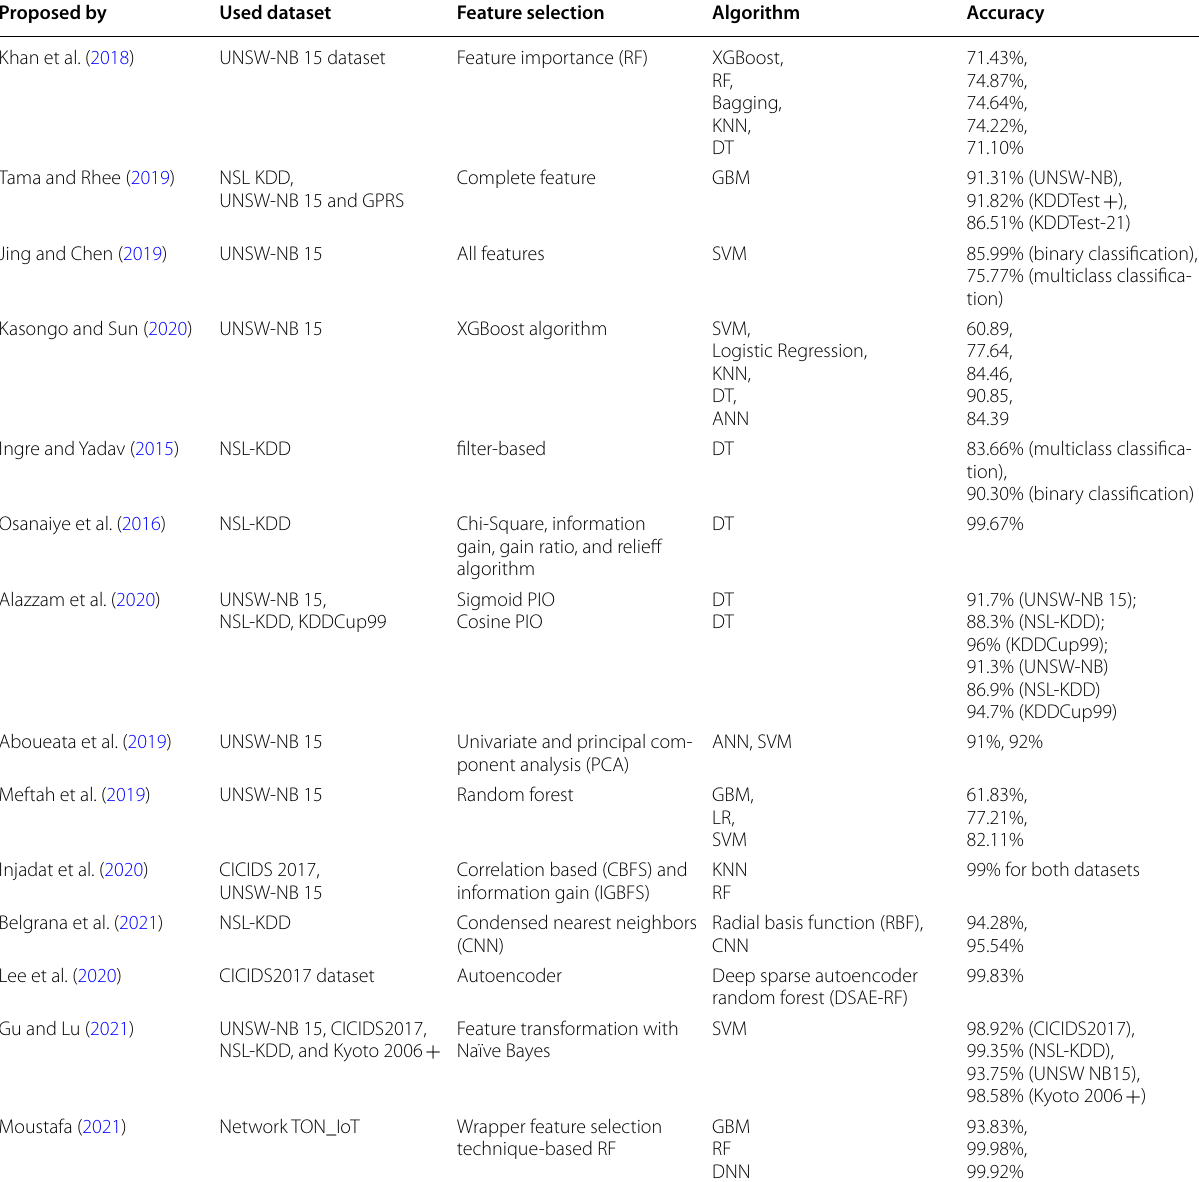
Table 1 Related works on IDS using ML models Proposed